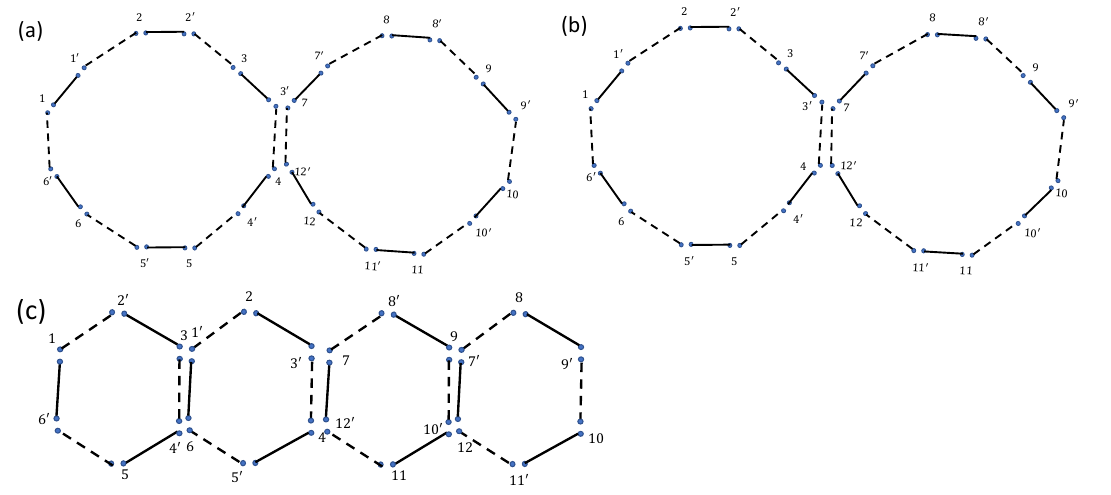
Figure 21 . Boundary conditions for the diagrams corresponding to the three terms in the second line of (B.6) are shown in order in (a), (b) and (c).